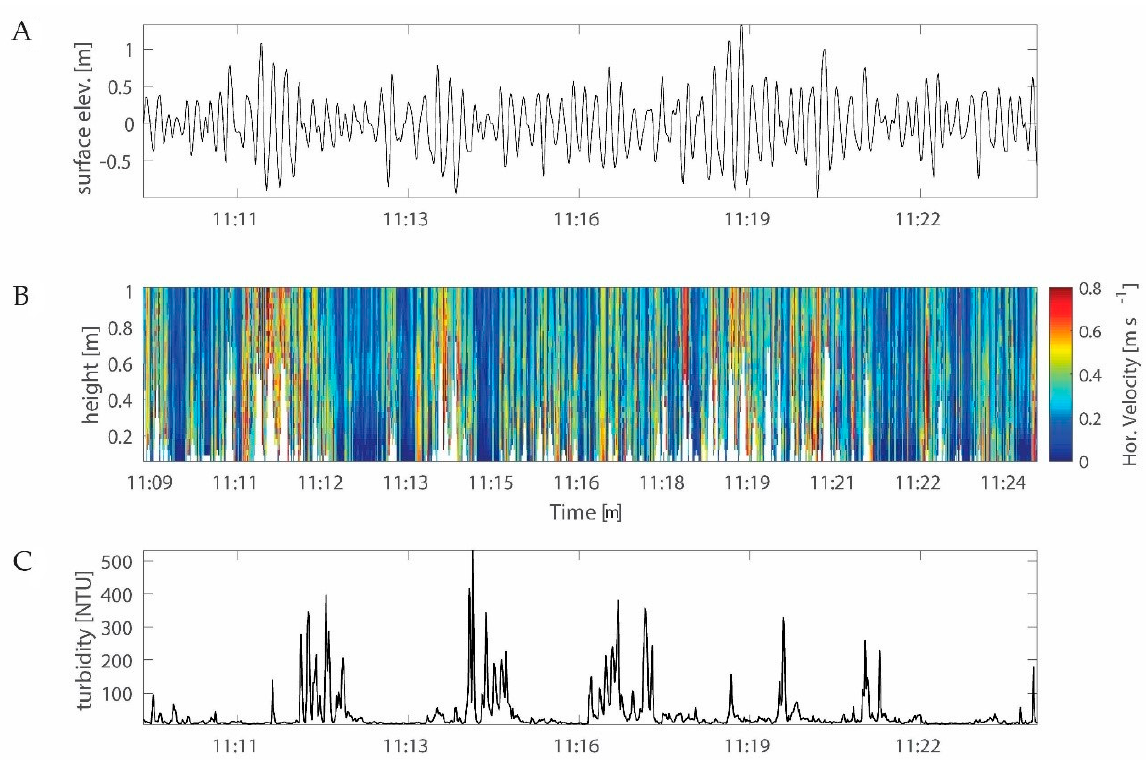
Figure 9. Hydrodynamic conditions during a 15 min interval, representative of the energetic sea state on Monday, 3 April 2017. ( A ) Water level fluctuations from mean sea level. ( B ) Horizontal velocity magnitudes in the water column at different heights above the bottom (hab). ( C ) NTU levels measured 0.15 m above the seafloor.